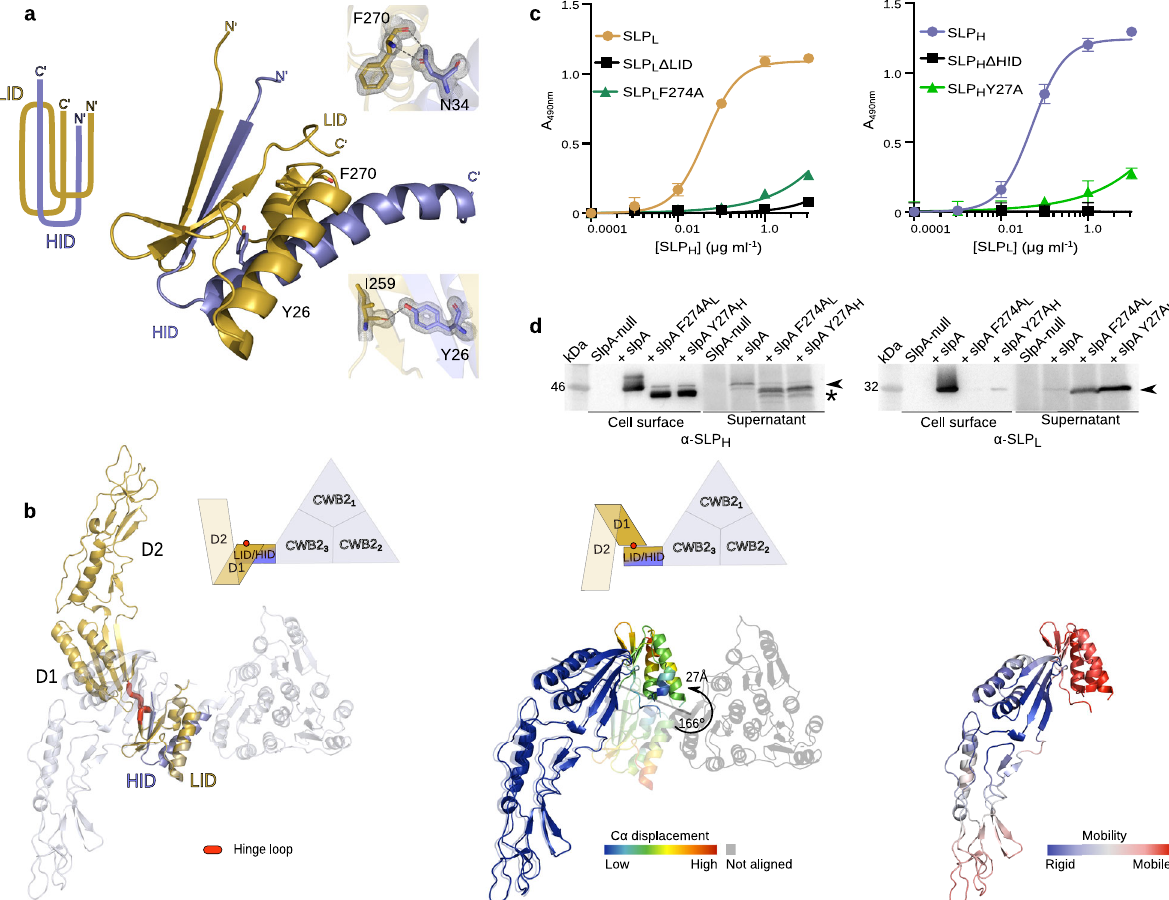
Fig. 2 Interactions and fl exibility in C. dif fi cile SLP H /SLP L (H/L) complex. a Paperclip organisation of the interacting domains LID/HID is maintained by a range of interactions, with selected interface residues identi fi ed in strain R7404 (SLCT-7b, PDB ID: 7ACW) depicted as sticks. 2m Fo- D Fc electron density map is shown on the interacting amino acid pairs as a grey mesh contoured at 1.5 σ . Speci fi c interatomic interactions identi fi ed with PDBePISA are represented as a dashed line. b Superimposing structures of SLP L /HID (gold/slate blue, PDB ID: 7ACV) onto the native complex of SlpA R7404 (SLCT-7b, PDB ID: 7ACX) (blue/white) reveals the fl exibility of the LID-D1 linker, as illustrated by rotation of D1-D2 domains in relation to fi xed position of LID/HID motif (left). The hinge loop enabling this conformational fl exibility (determined by DynDom6D) is coloured in red. The backbone displacement (coloured from blue – low, to red – high C α displacement deviation) is shown on the alignment of D1-D2 region of both structures (middle; SLP L /HID – opaque, H/L – semi-transparent) with the rotation angle of the LID/HID motif indicated with an arrow. Structural dynamics (right) of SLP L /HID, represented as increasing mobility (coloured blue – rigid, to red - mobile), calculated based on elastic network models implemented in DynOmics ENM version 1.0 server. c Probing of CD630 H/L complex interactions in vitro with ELISA, comparing effects of intact SLP L (gold circles), SLP H (slate blue circles), variants lacking interacting domains (black squares) and substitution mutants of F274A (structurally equivalent to F270 in R7404 LID/HID depicted in c , dark green triangles) and Y27A (structurally equivalent to Y26 in R7404 LID/HID in c , light green triangles) on H/L complex formation. Graphs represent mean ± standard deviation (SD) of n = 3 experiments, with least-squares curve fi t of product formed upon the interaction of the two subunits. Source data provided in Source data fi le. d Western blot of cell surface extracts and culture supernatants, detecting (black arrowhead) SLP H (left) and SLP L (right) in strains devoid of endogenous slpA and expressing plasmid-borne SlpA CD630 native protein or variants with either F274A L or Y27A H substitution mutants in SLP L or SLP H (denoted in subscript), respectively (n = 1). Detected product of partial degradation of SLP H indicated with an asterisk. Source data provided in Source Data fi